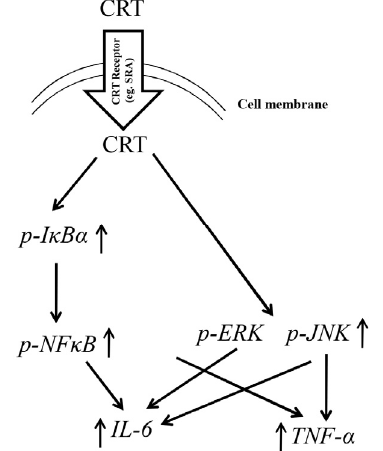
Figure 6. Proposed model of inflammatory cascades induced by CRT in